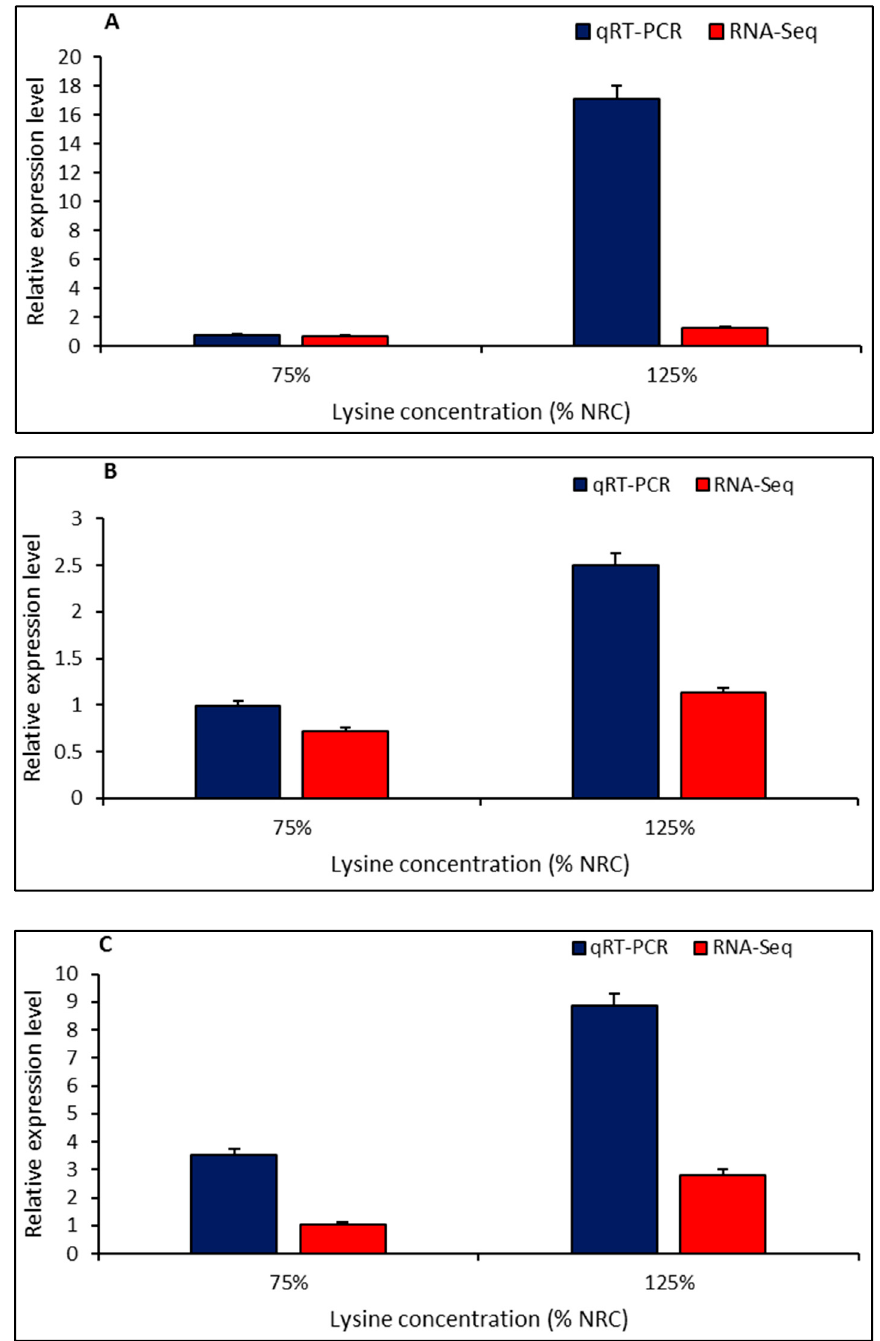
Figure 4. Validation of RNA-seq data. Expression levels of three DEGs (( A ): SLC7A1; ( B ): SLC7A2; ( C ): SLC7A3) in the liver tissues of high- and low-lysine-fed broiler chickens. qRT-PCR: quantitative real-time polymerase chain reaction; RNA-seq: RNA sequencing. Results from qRT-PCR of the three genes were calculated using the 2 −∆∆ C t method while the RNA-seq expression levels were estimated according to fragments per kilobase of transcripts per million mapped fragments (FPKM).